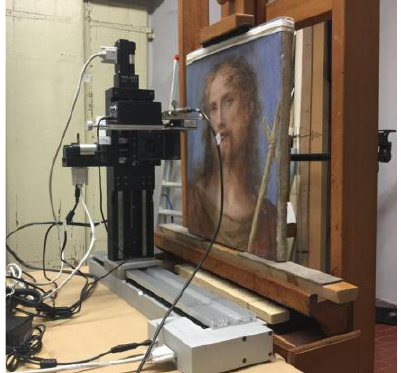
Fig. 5. Portable ENEA Imaging system applied to a “Fres- co” painting on the “tavella”—St. John Baptist—by Ales- sandro Gherardini